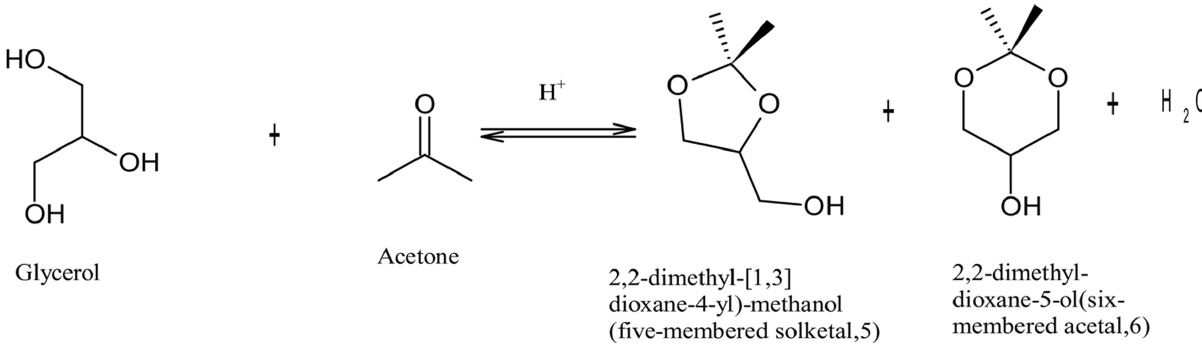
Figure 1: Acid-catalysed reactions of glycerol and acetone to produce